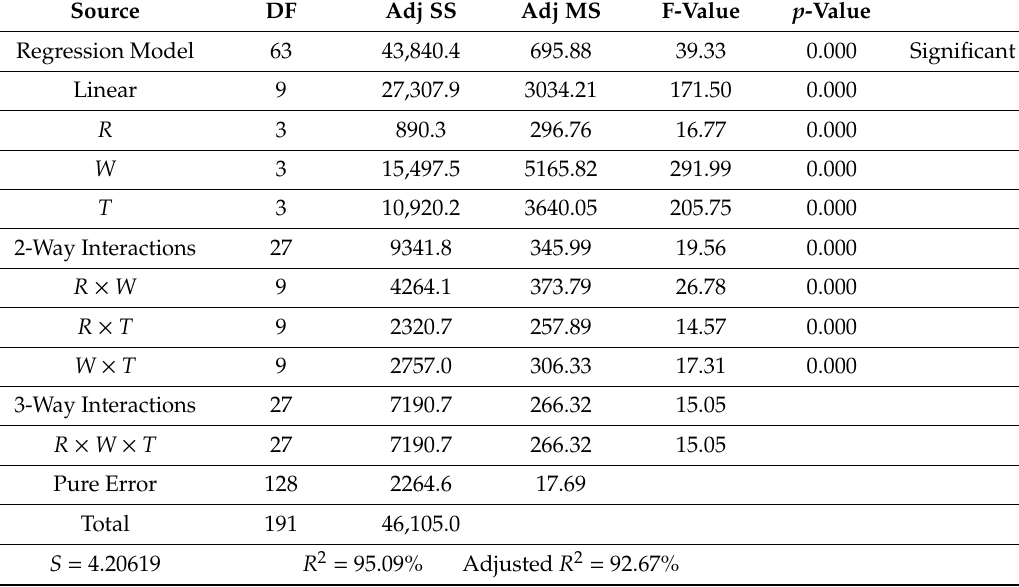
Table 5. Analysis of variance analysis for tensile strength.